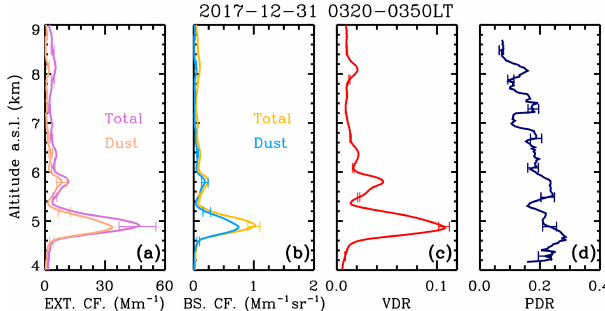
Figure 11. Profiles of the (a) dust and total (dust + non-dust) ex- tinction coefficient, (b) dust and total (dust + non-dust) backscatter coefficient, (c) volume depolarization ratio δ , and (d) particle de- polarization ratio δ p derived by the 532nm polarization lidar during 03:20–03:50LT on 31 December 2017. Horizontal error bars denote the relative errors of each parameter.